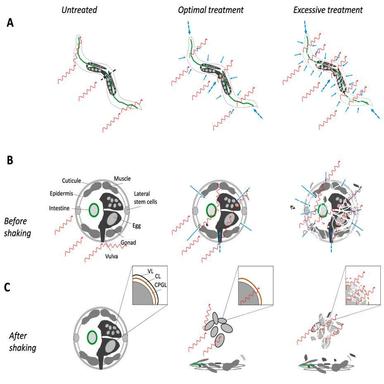
Tissue-light interaction for nematode and eggs at different treatment levels. A: nematode damage/light/alkaline hypochlorite relation. B: Transversal viewpoint of the nematode damage/ light/alkaline hypochlorite relation in non-shaken nematodes. C: Scheme of the egg/light/hypochlorite relation after shaking with. : alkaline hypochlorite access via anatomic orifices; : alkaline hypochlorite contact on skin; : light. VL: viteline layer; CL: chitosin layer; CPGL: chondroitin proteoglycan layer.